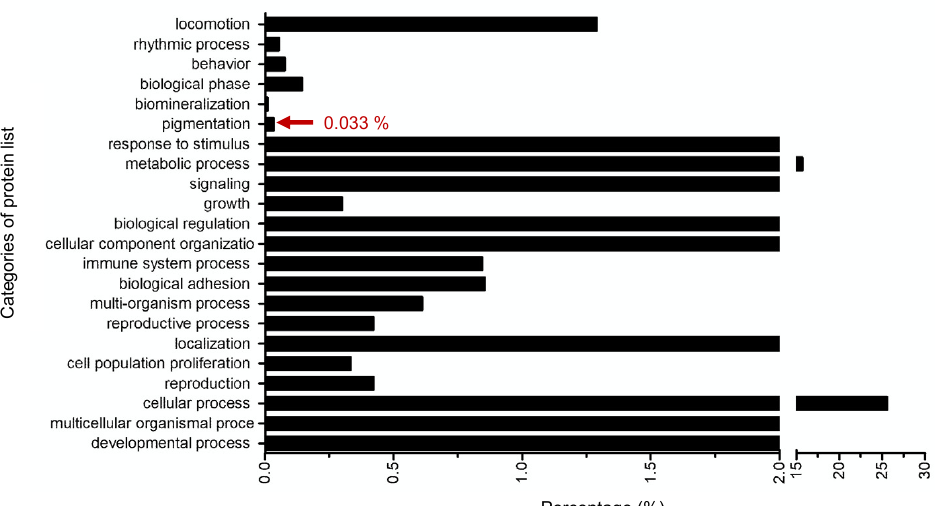
Figure 4. Gene Ontology (GO) enrichment analysis of the proteome dataset represented in the bar chart according to their biological functions. Enrichment analysis classified the protein dataset into 22 groups as the percentage of the total proteome. Three proteins were classified as pigmentation, which was three proteins (0.033%) of the proteome data.